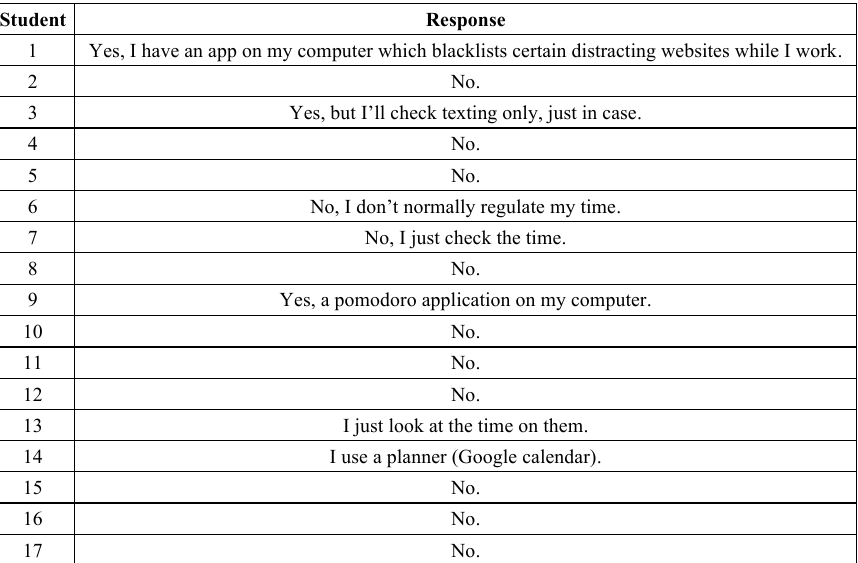
Table 5. Question 5: Do you use any applications on your phone